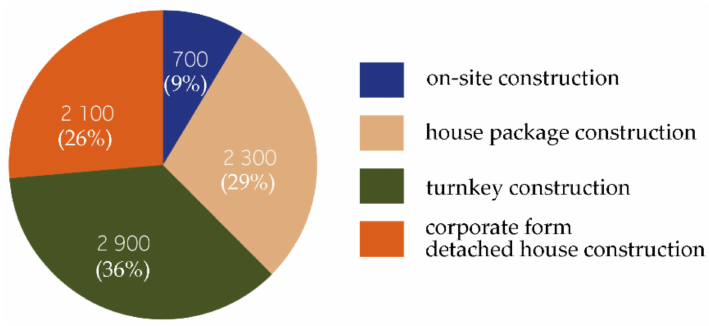
Figure 3. Small house construction in Finland by construction type.